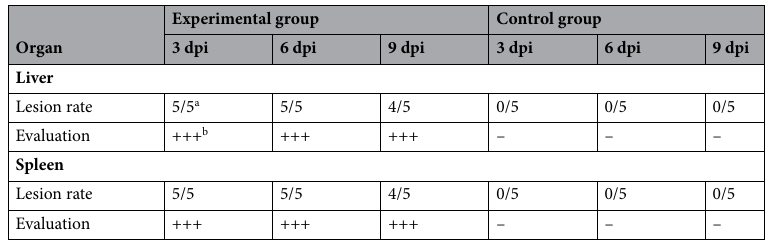
Table 1. Gross lesions in chickens of two different groups at 3 dpi, 6 dpi and 9 dpi. a Number of chickens exhibiting gross lesions in the sacrificed chickens infected with NDRV. b Severity of gross lessions: −, no gross lesions; +, mild gross lesions; ++, moderate gross lesions; +++, severe gross